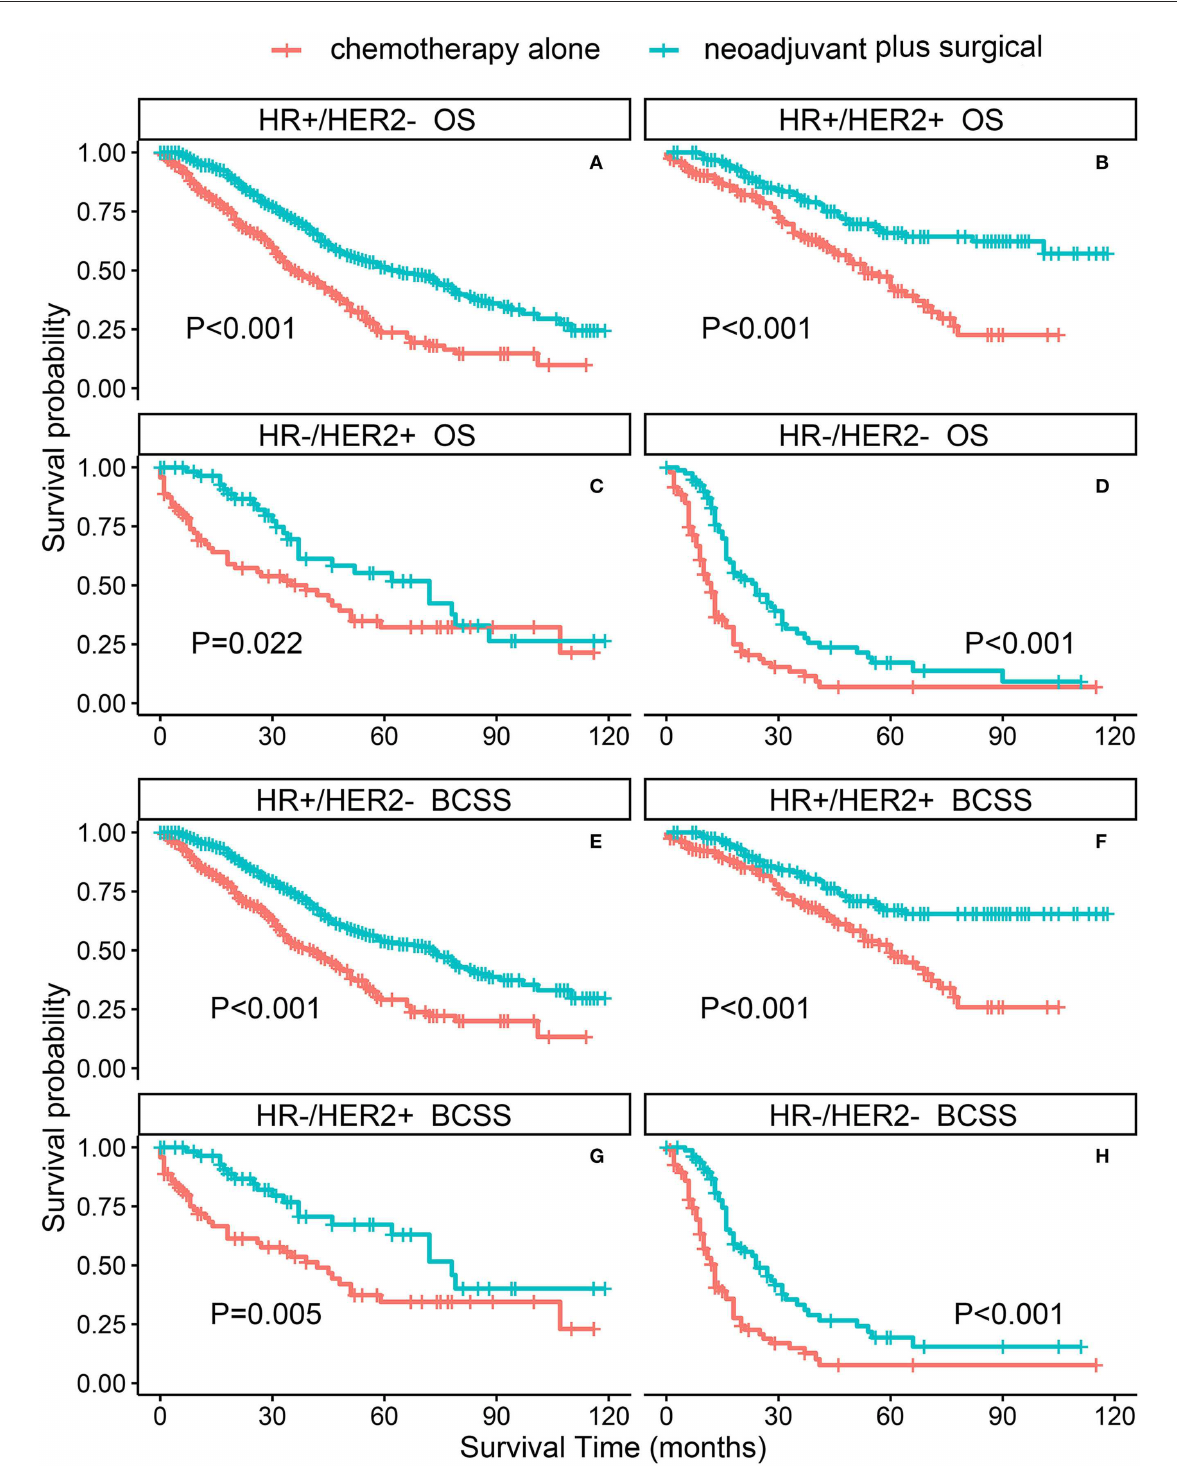
FIGURE3 PSM-adjusted OS and BCSS of BMBC patients with neoadjuvant chemotherapy plus surgical treatment and chemotherapy alone (stratified by molecular subtype). Kaplan–Meier (K–M) survival analysis: (A) OS of BMBC patients with HR + /HER2- subtype; (B) OS of BMBC patients with HR + /HER2 + subtype; (C) OS of BMBC patients with HR–/HER2 + subtype; (D) OS of BMBC patients with HR–/HER2– subtype; (E) BCSS of BMBC patients with HR + /HER2– subtype; (F) BCSS of BMBC patients with HR + /HER2 + subtype; (G) BCSS of BMBC patients with HR–/HER2 + subtype; (H) BCSS of BMBC patients with HR-/HER2- subtype. OS, overall survival; BCSS, breast cancer-specific survival; BMBC, bone metastatic breast cancer; HR, hormone receptor; HER2, human epidermal growth factor receptor 2; PSM, propensity score